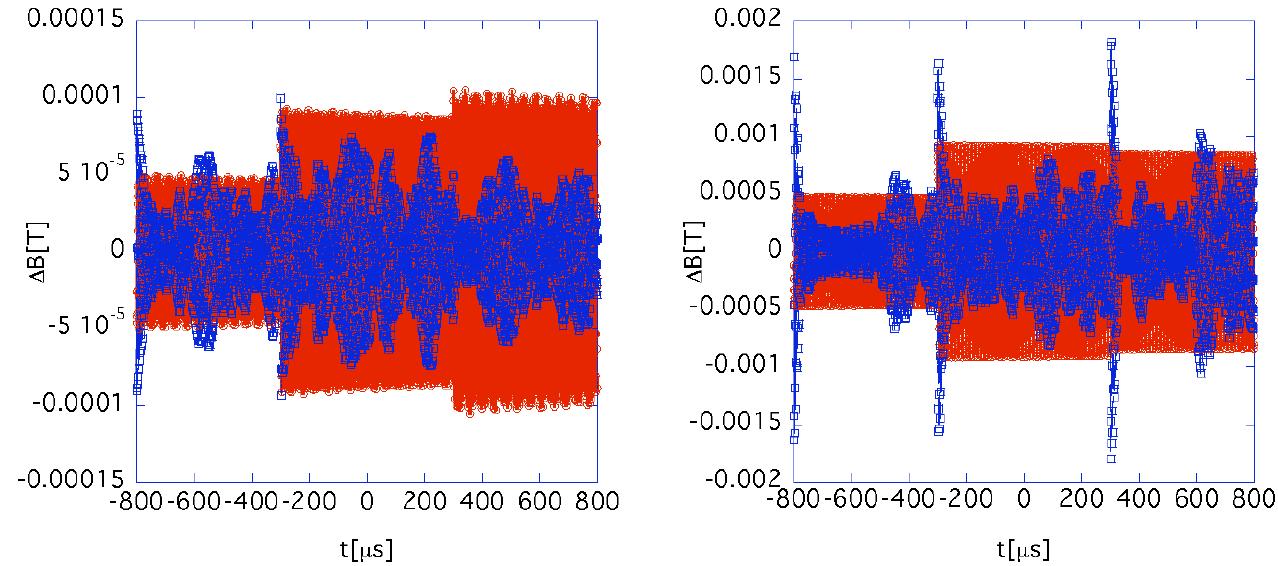
FIG. 25. (Color) The comparison of the field modulation (theoretical results) obtained by Eqs. (34)–(38) with that done by the formula where the mutual inductances are neglected. The left figure represents the case that 20 capacitors are working on the lower side of the chamber. The right figure represents the case where all the capacitors ( k ¼ 100 ), which cover the chamber, are working. The red points represent the results calculated by Eqs. (34)–(38) and blue points do those done by the formula where the mutual inductances are neglected. It is indispensable to consider the effect of mutual inductance, in order to evaluate the field modulation correctly.